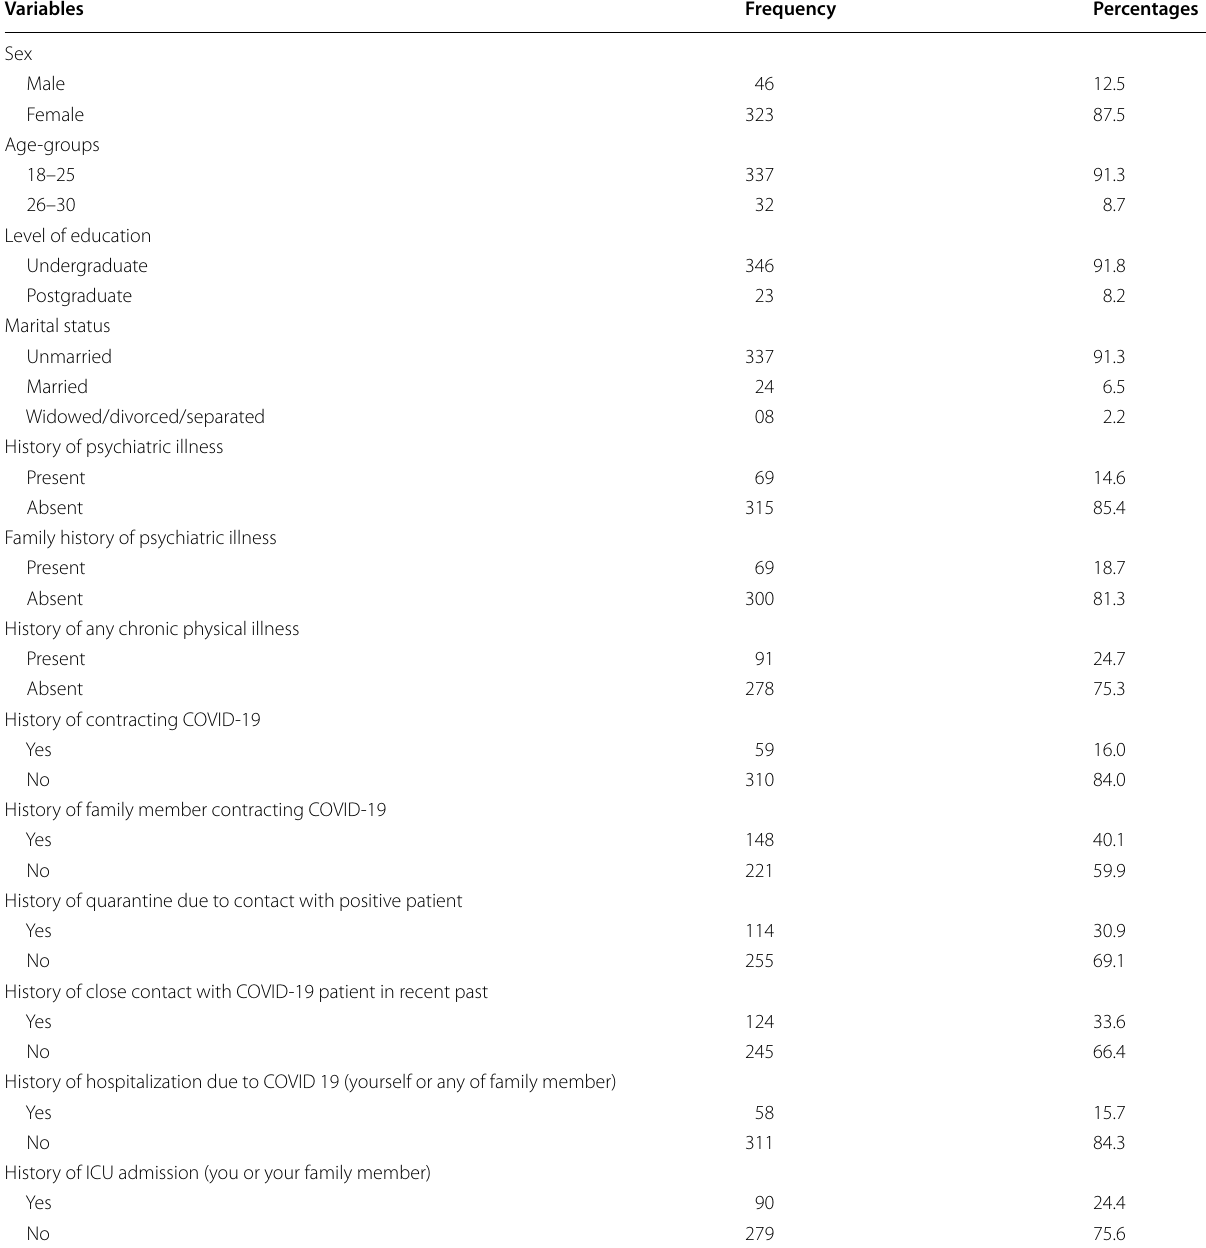
Table 1 Socio-demographic characteristics of the study participants ( N